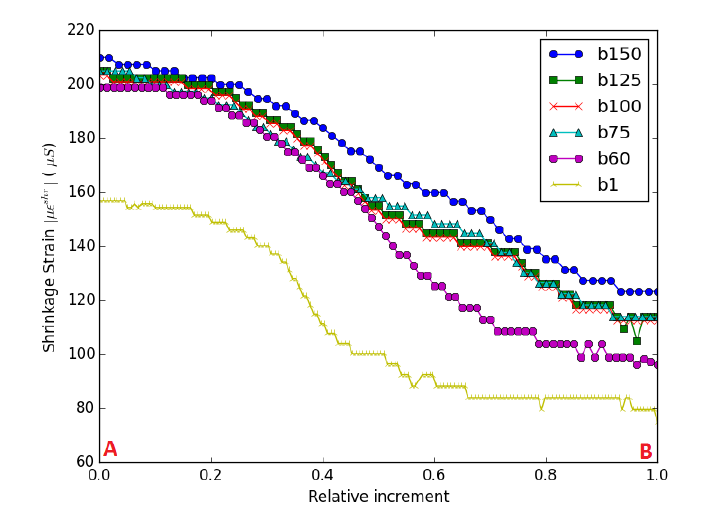
a ratios limited between the first damage and the b